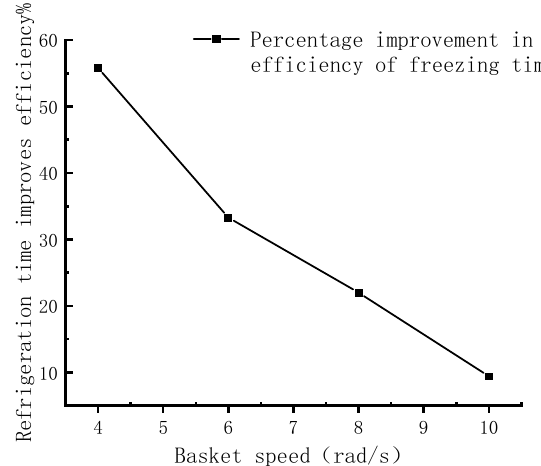
Figure 11. Histogram of load frame speed and freezing time.